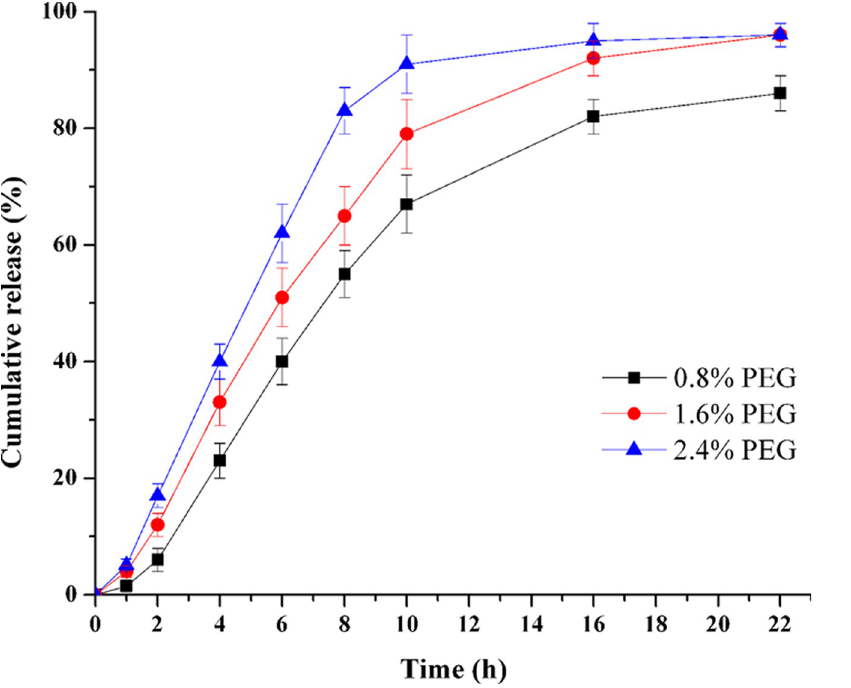
Fig 10. Effect of PEG level in coating membrane on TPM release (n =